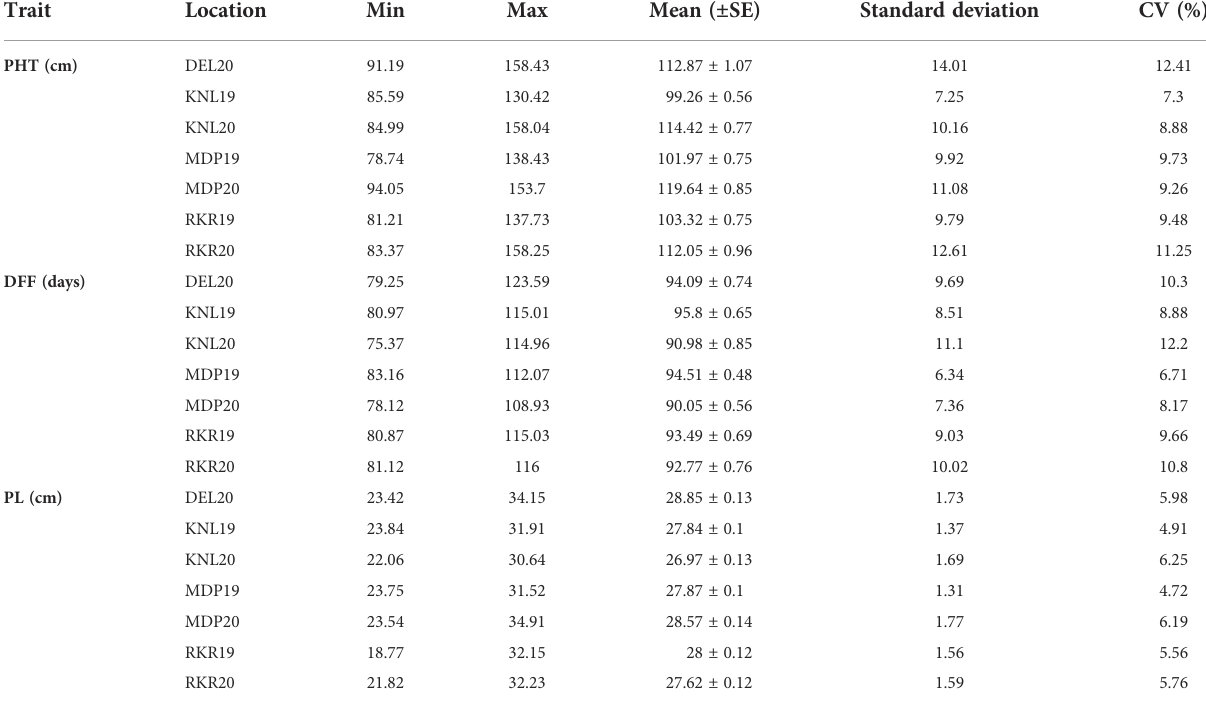
TABLE 1 Summary statistics of three agronomic traits recorded on 172 breeding lines evaluated across seven environments.